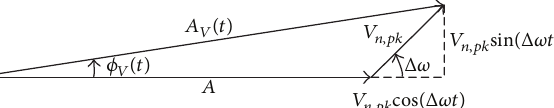
Figure 4: Phasor diagram of AM and PM components in magneti- cally coupled